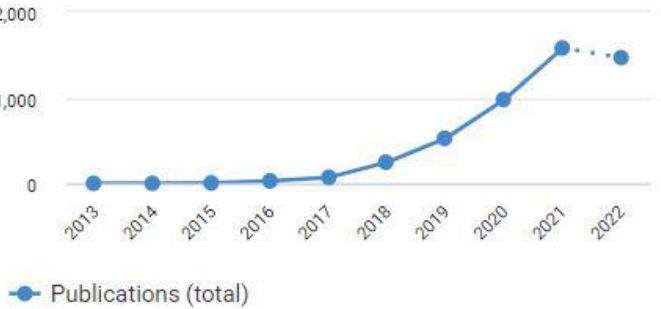
Figure 2. Trend of research publications with Blockchain technology in the domains of Electrical and Electronics Engineering (From 2013 to September 2022).